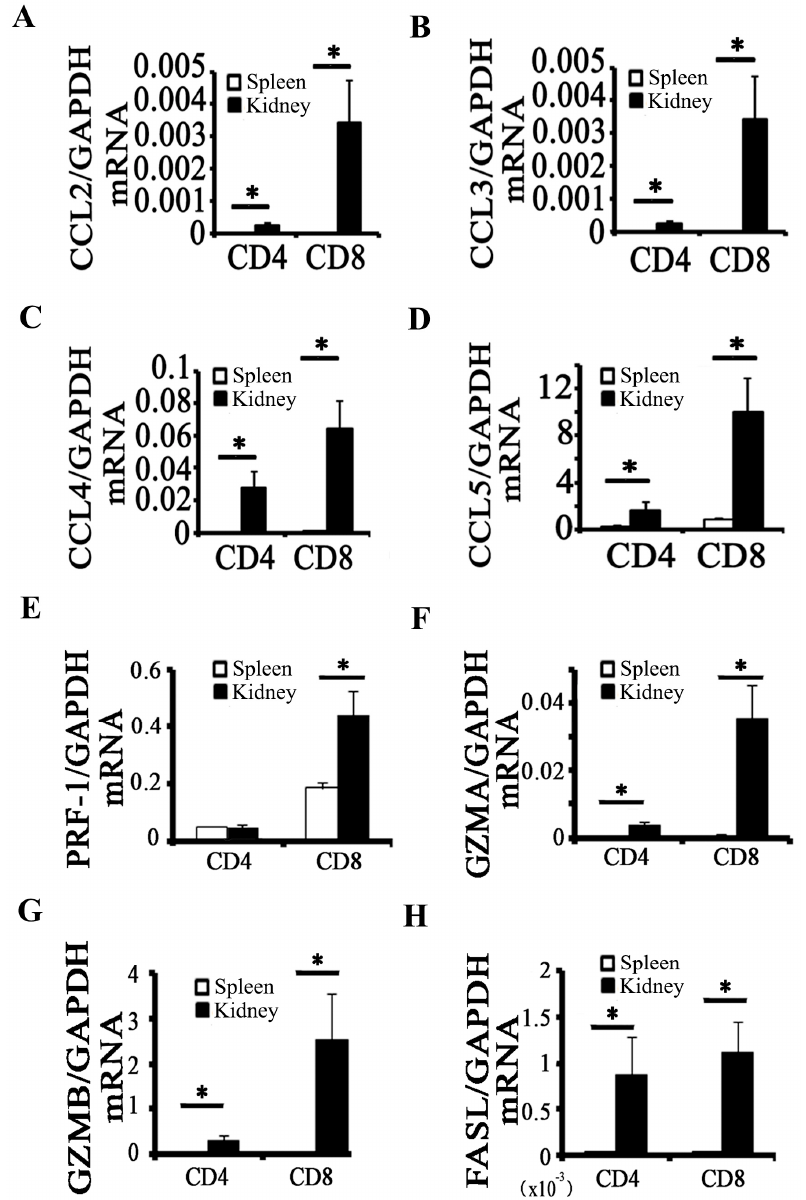
Figure 2. CD8 + T cell activation requires an inflammatory microenvironment. CD4 + T cells (CD45 +